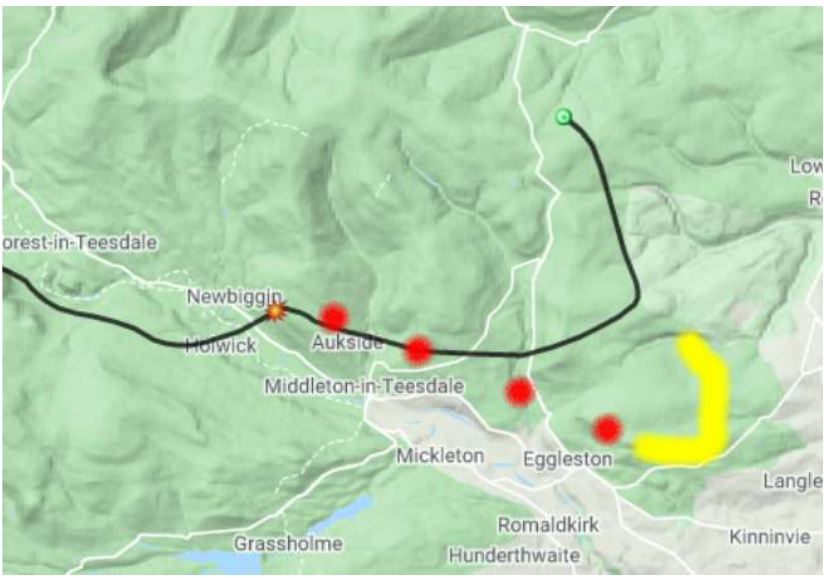
Figure 28. Predicted trajectory (black line), actual trajectory (red dots) and estimated descent (yel- low line).